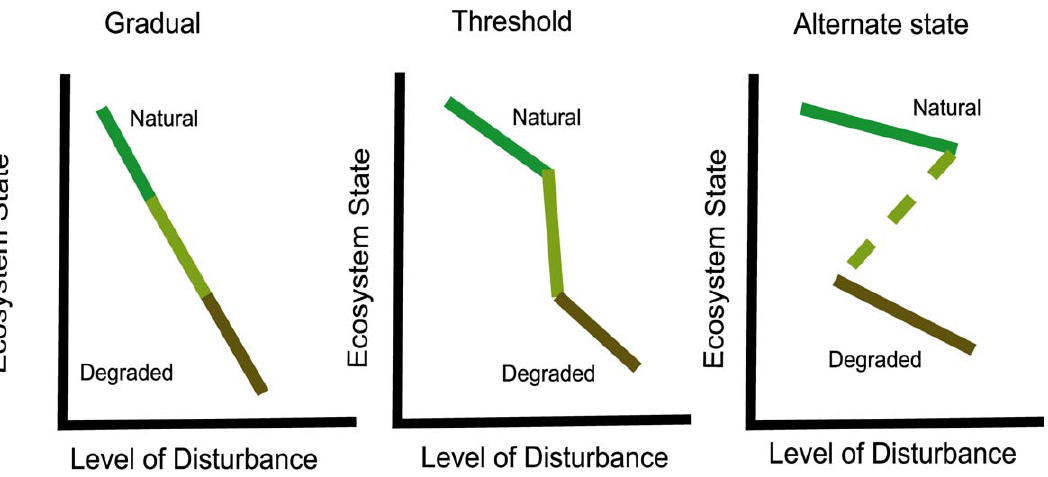
Figure 1. Different potential ways that ecosystem state may change in relation to the level of environmental disturbance. Solid lines denote pathways of state changes from natural to degraded conditions, and the dashed line indicates a transition where the system jumps from a natural to a degraded state. The figure illustrates three general scenarios. Ecosystems may undergo gradual degradation with a rise in disturbance level and may recovery gradually as the disturbance is abated. Ecosystems may exhibit threshold-like behavior in which a certain level of disturbance causes an abrupt change in state and disturbance abatement causes an abrupt ‘‘up-hill’’ return in ecosystem state. Finally, an ecosystem may exhibit a threshold shift in ecosystem state that may only be recoverable with a large turnaround of the critical environmental parameter or disturbance that caused the system to shift from the original state. The scientific challenges in restoration ecology are: characterizing what a natural ‘‘green’’ state is; identifying how long a perturbation must be in place to determine whether the system changes gradually or abruptly; and how long it will take to reverse the effects of a disturbance. Figure is adapted from [10].